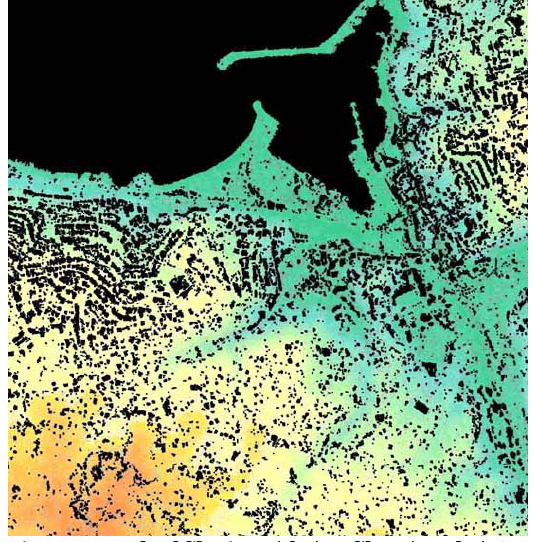
Figure 9. Result of filtering – black = filtered + Black Sea colour corresponds to terrain height